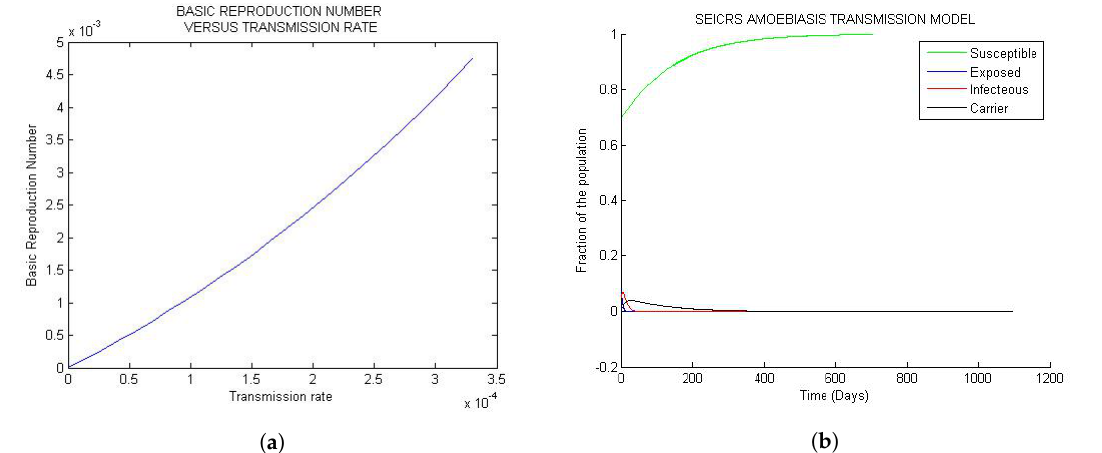
Figure 1. General trends of the model for values of R 0 small than one: ( a ) Curve of the R 0 versus β ; ( b ) 25 solution curves’